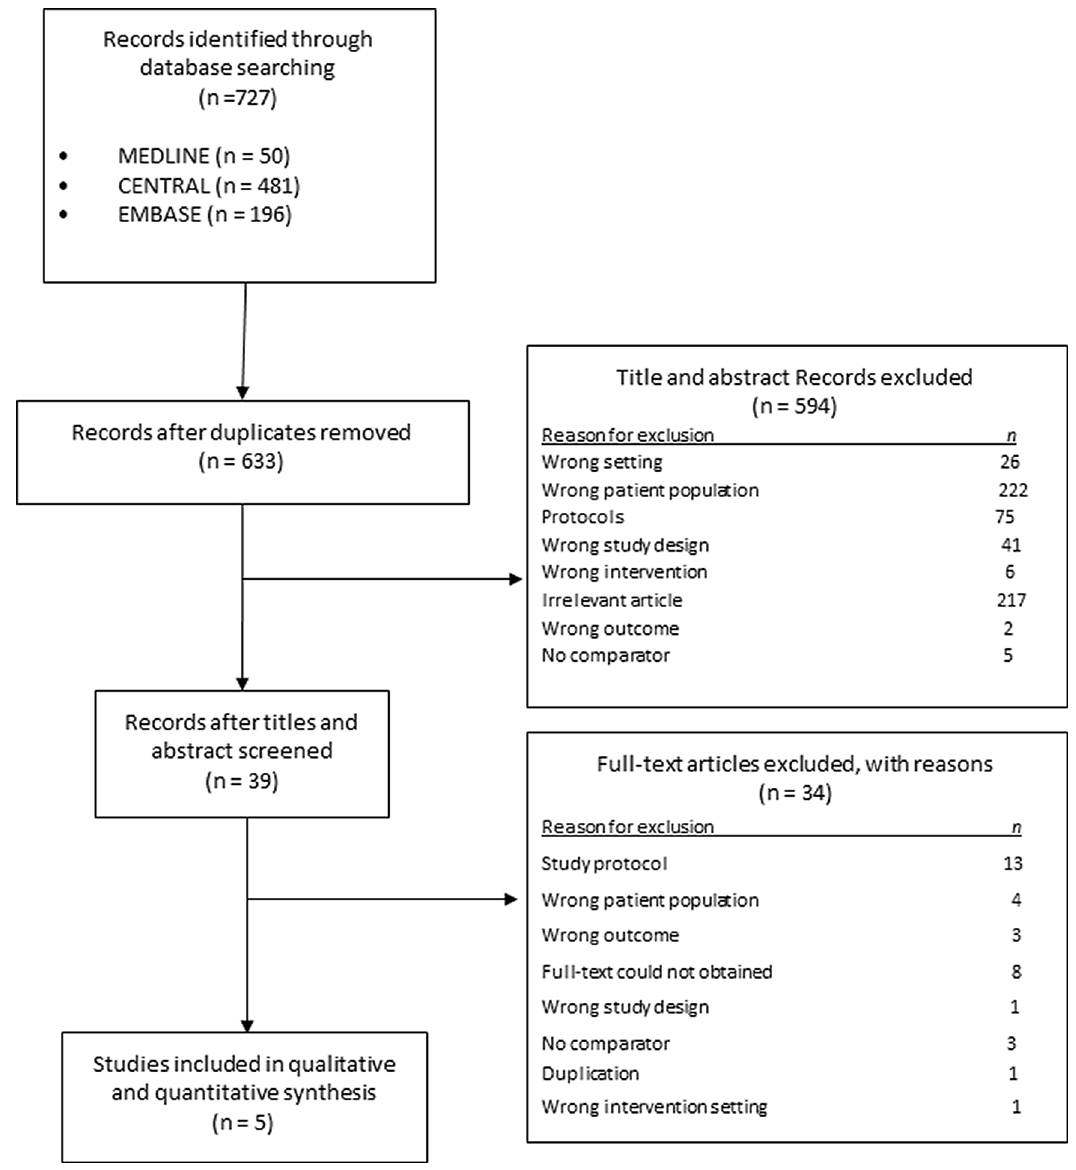
Figure 1. PRISMA flowchart for study